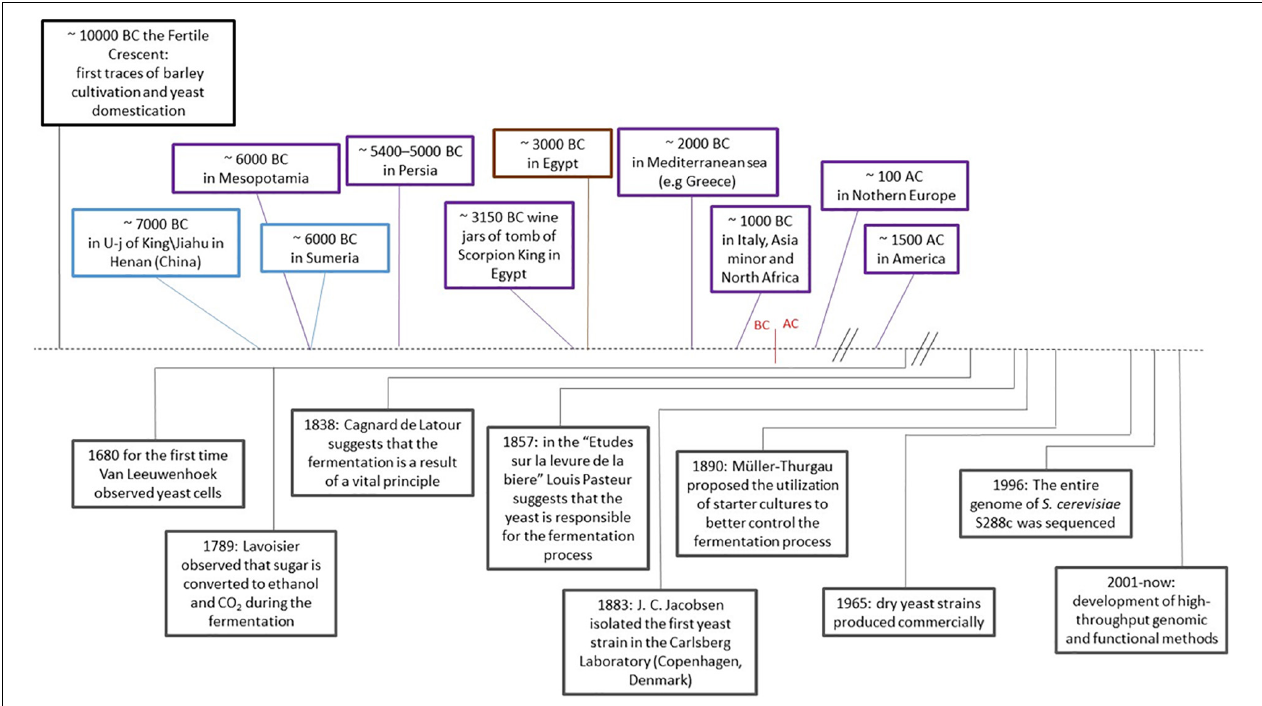
FIGURE 1 | History of fermentation and yeast domestication. S. cerevisiae and human activities related to the production of fermented products. In the timeline: on the top of the dashed line, the oldest traces of S. cerevisiae across the human history and geography. Blue: fermented products; purple: wine; brown: bakery products. Below the dashed line, events related to S. cerevisiae in the history of fermentation and scientific advancements.